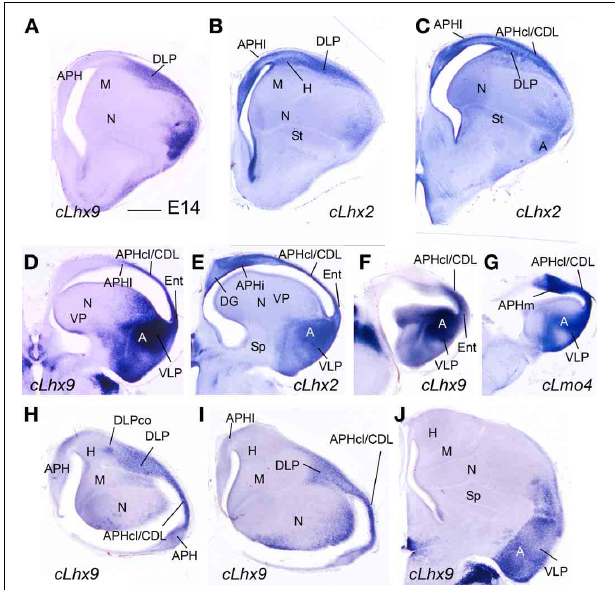
FIGURE 10 | Expression of several genes in the chicken embryonic telencephalon at intermediate stages. (A–G) Digital images of coronal sections of chicken embryonic telencephalon (E14), at intermediate (A–C) or caudal (D–G) levels, hybridized for cLhx2, cLhx9 , or cLmo4 . (H–J) Digital images of horizontal sections of chicken embryonic telencephalon (E14), from top (H) to bottom (J) , hybridized for cLhx9 . Note the distinct genetic profile of DLP and VLP. For abbreviations see list. Scale bar: (A) = 1mm (applies to